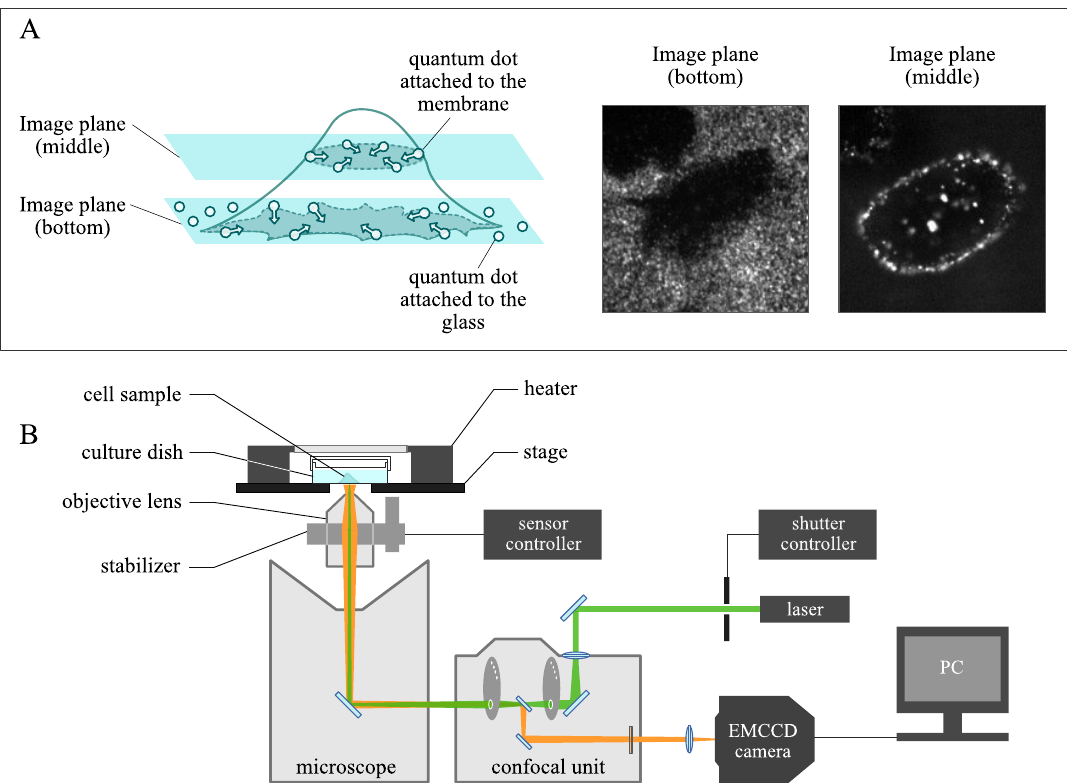
Figure 2. ( A ) Comparison between two cell images captured at the bottom and middle of the cell height. The imaging plane was empirically determined at 4µm, considering the trade-off between signal-to-noise ratio and the intracellular area to be analyzed. ( B ) Structure of imaging system based on fluorescence confocal